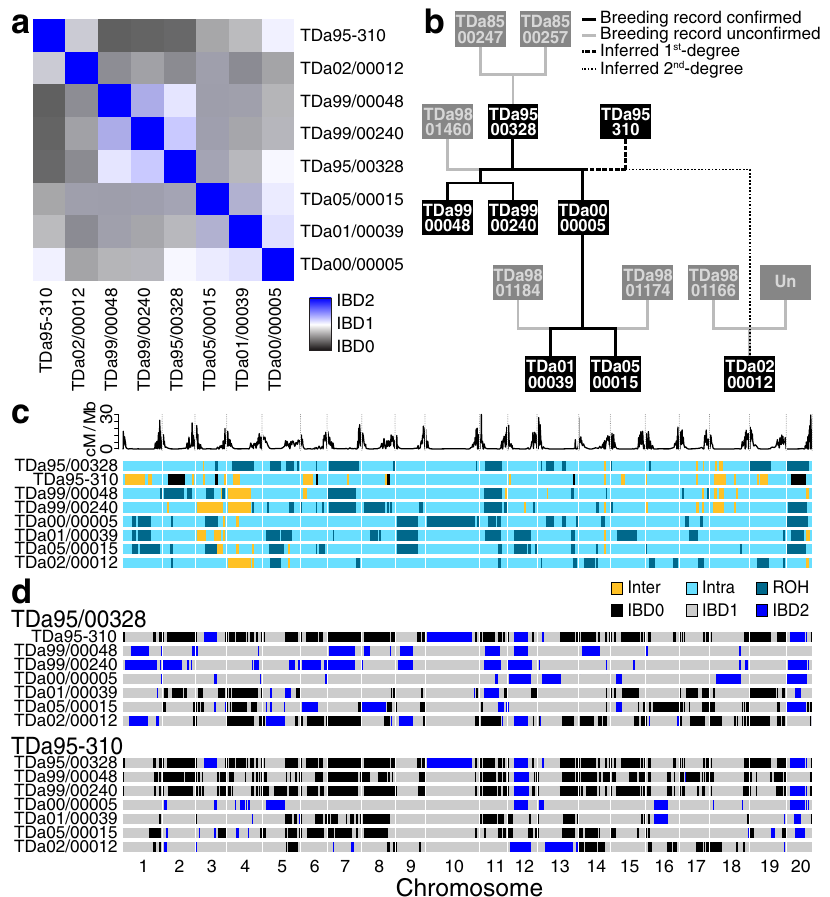
Fig. 4 Relationships between eight deeply sequenced D. alata breeding lines. a Matrix of identity-by-descent (IBD) relatedness between all pairs of individuals (Supplementary Data 3). Blue represents the degree of diploid genome identity (IBD2); white, one haplotype (IBD1); and black, no shared haplotypes (IBD0). b Pedigree of relationships. Sequenced individuals are represented in black boxes with white text, while individuals not sequenced are in gray. Relationships known via IITA records (Supplementary Table 1) are drawn with solid lines. Relationships that could be con fi rmed using direct sequence comparison are highlighted with solid black lines, and those that could not be are colored grey. Inferred cryptic relationships are indicated with broken lines ( fi rst- and second-degree relations are represented as thick dashed and thin dotted lines, respectively). Unexpectedly, TDa95-310 is a parent of TDa00/ 00005 and a likely second-degree relative of TDa02/00012. c Regions of heterozygosity, autozygosity, and possible introgression. Within a background of intraspeci fi c genetic variation (light cyan), large homozygous blocks (runs of homozygosity [ROH], dark cyan) appear common in the resequenced individuals, suggesting autozygosity from historical inbreeding. In addition, large blocks of exceptionally high heterozygosity (yellow) can also be observed, indicating possible introgressions (interspeci fi c variation introduced via hybridization) in one or more of the unsampled pedigree founders. The recombination rate along each chromosome is shown in the track above. d Haplotype sharing between TDa95/00328 and all other resequenced individuals, and TDa95-310 and all others. Regions of the genome where an individual shares two haplotypes (i.e., they are IBD2) with TDa95/00328 (or TDa95-310) are highlighted in blue, one shares haplotype (IBD1) in gray, or shares no haplotypes (IBD0) in black. Source data are provided as a Source Data fi